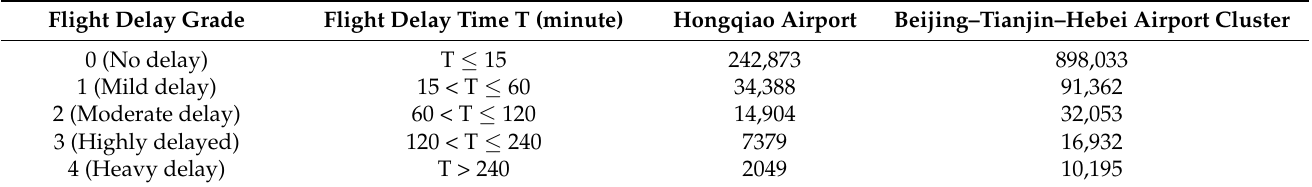
Table 2. Flight delay level